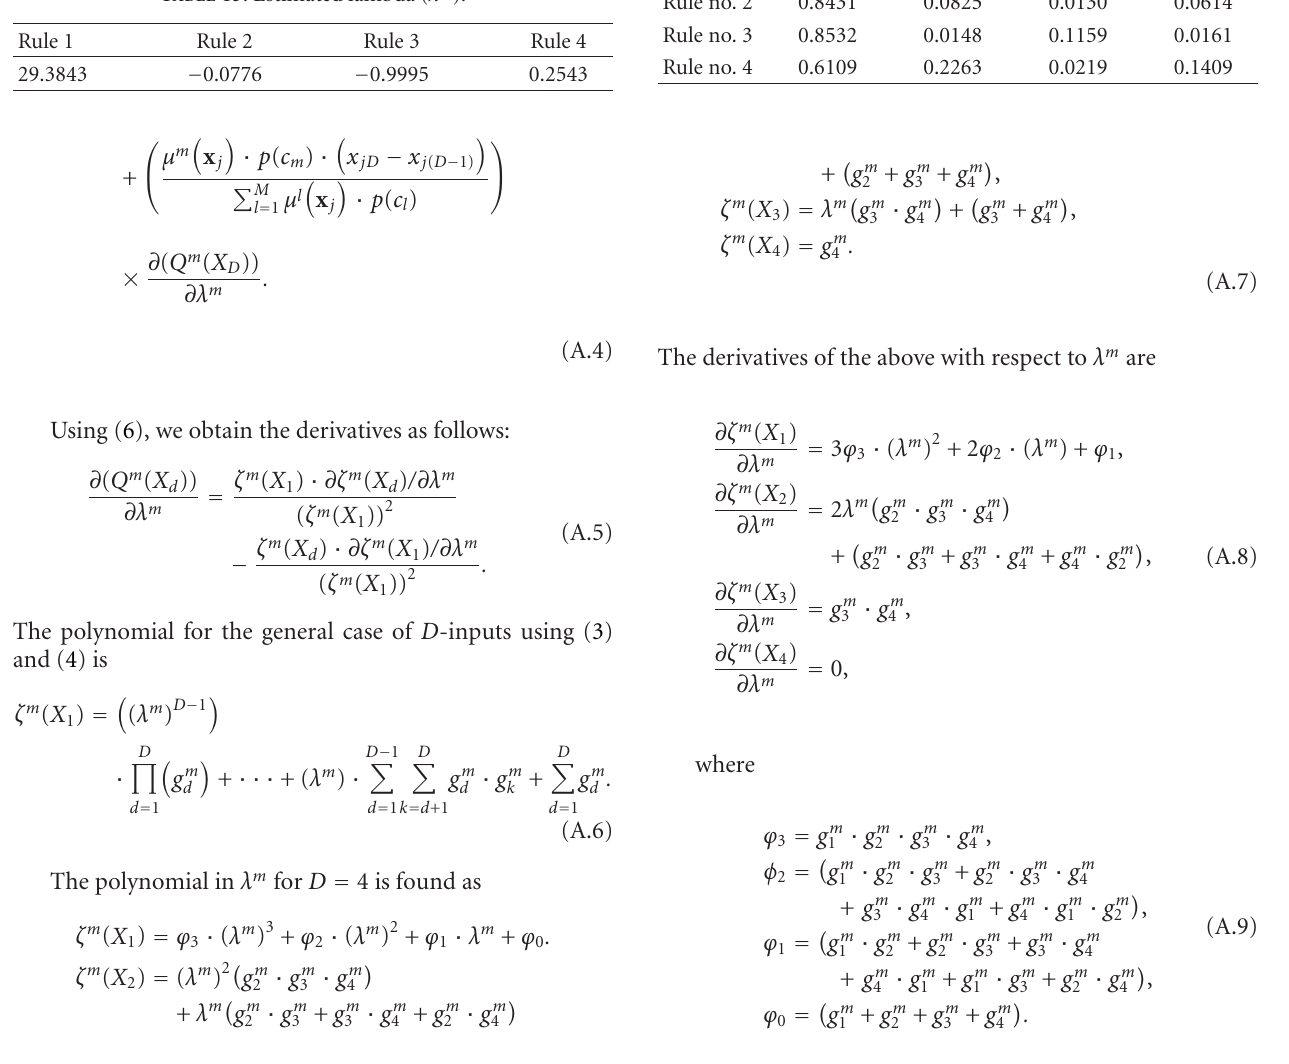
Table 15: Estimated lambda ( λ m ).